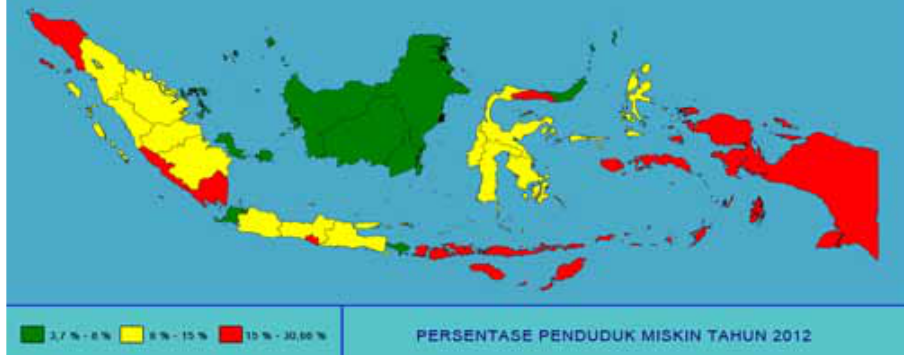
figure 1 below. Figure 1 The Distribution of Poor People in Indonesia for Year